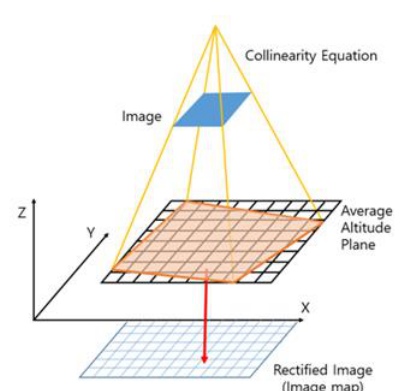
Figure 5. Individual orthophoto